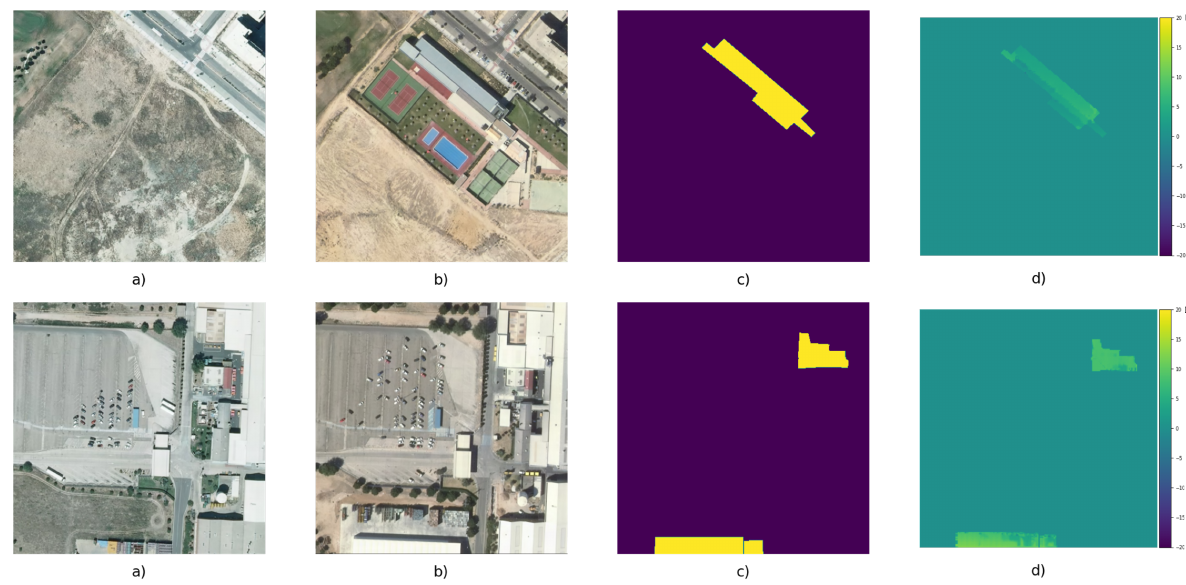
Figure 9. Two examples from the proposed dataset. a) 2010 optical image, b) 2017 optical image, c) 2D CD map, d) 3D CD map, where the colour bar is expressed in